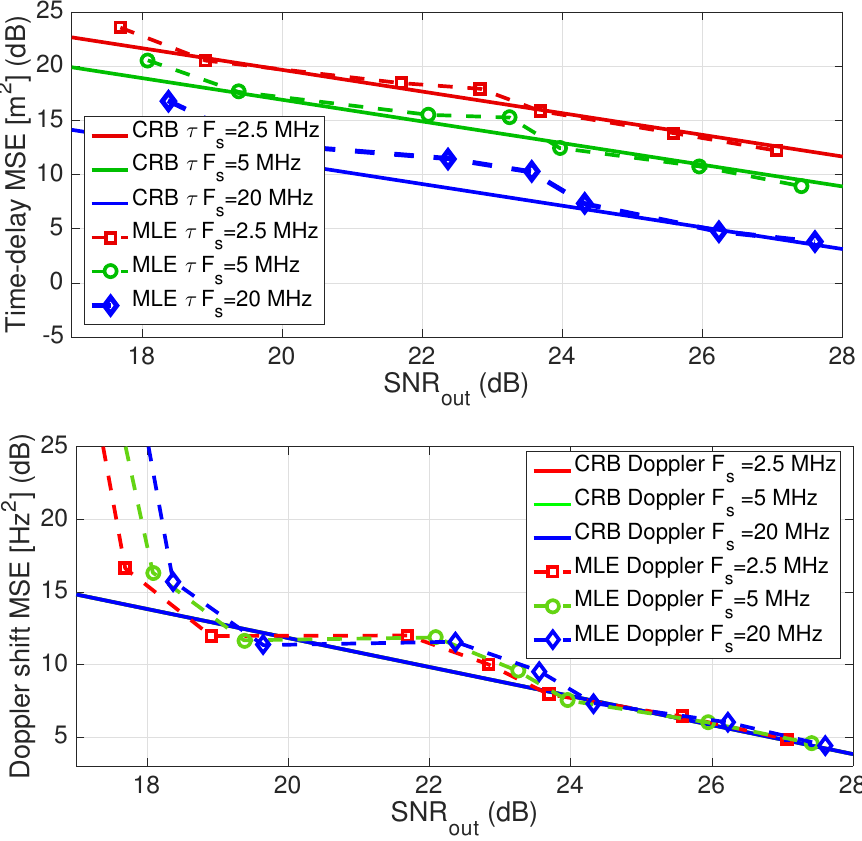
Figure 2. Time-delay ( Top ) and Doppler frequency shift ( Bottom ) CRB and MLE for a real-life GPS L1 C/A signal and different sampling rates: 2.5 MHz, 5 MHz and 20